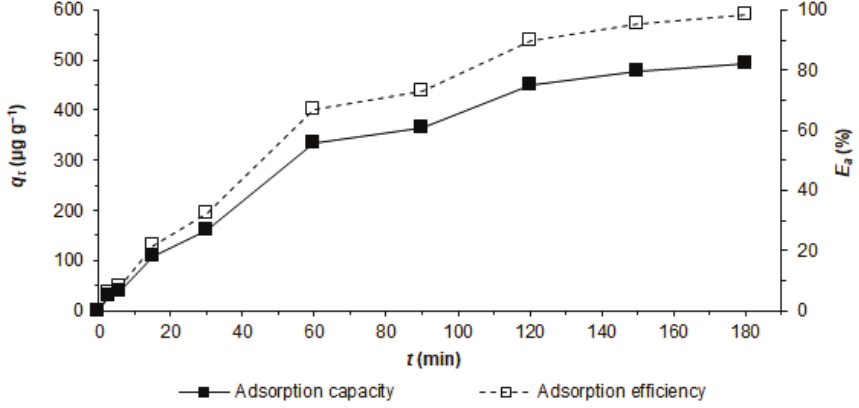
Fig. 2 – Impact of contact time on the adsorption capacity and adsorption efficiency of GFO for As(V) (As(V) initial concentration 1000 μg L −1 , volume of solution 0.1 L, contact time 180 min, amount of adsorbent 0.2 g, neutral pH, temperature 20±2 °C, agitation speed 150